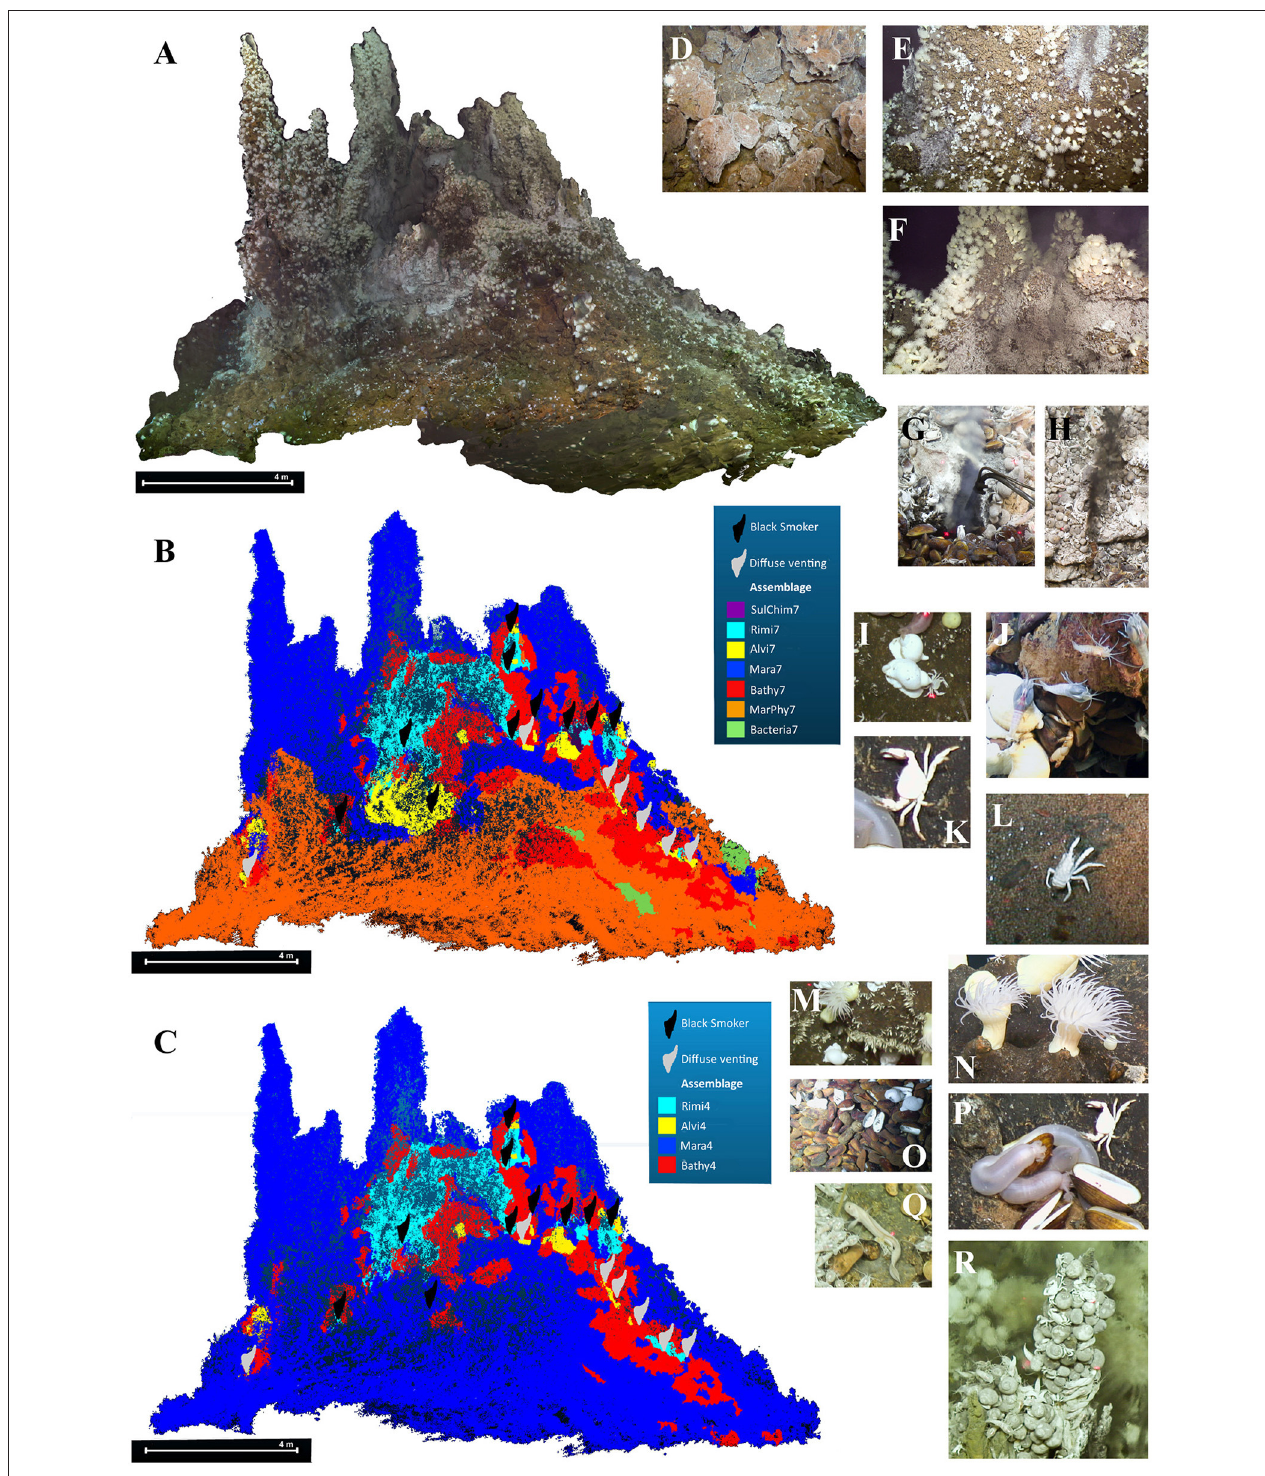
FIGURE 4 | South side structure from motion textured mesh of the 3D chimney reconstruction, detail of the textured surface and manually assigned faunal assemblages. (A) Textured reconstructed chimney. (B) Faunal assemblage distribution assigned by dominant taxa. (C) Faunal assemblage distribution based on k-medoid clustering. (D) Sulfide blocks of the chimney complex. (E) Overview of mussel and shrimp aggregations. (F) Overview of shrimp and anemone aggregations. (G) Diffuse fluid exit. (H) Black fluid exit. (I) Phymorhynchus spp.. (J) Rimicaris kairei . (K) Austinograea rodriguezensis . (L) Munidopsis pallida . (M) Neolepas marisindica. (N) Maractis sp.. (O) Bathymodiolus septemdierum . (P) Chiridota sp.. (Q) Zoarcidae gen. sp.. (R) Alviniconcha marisindica .